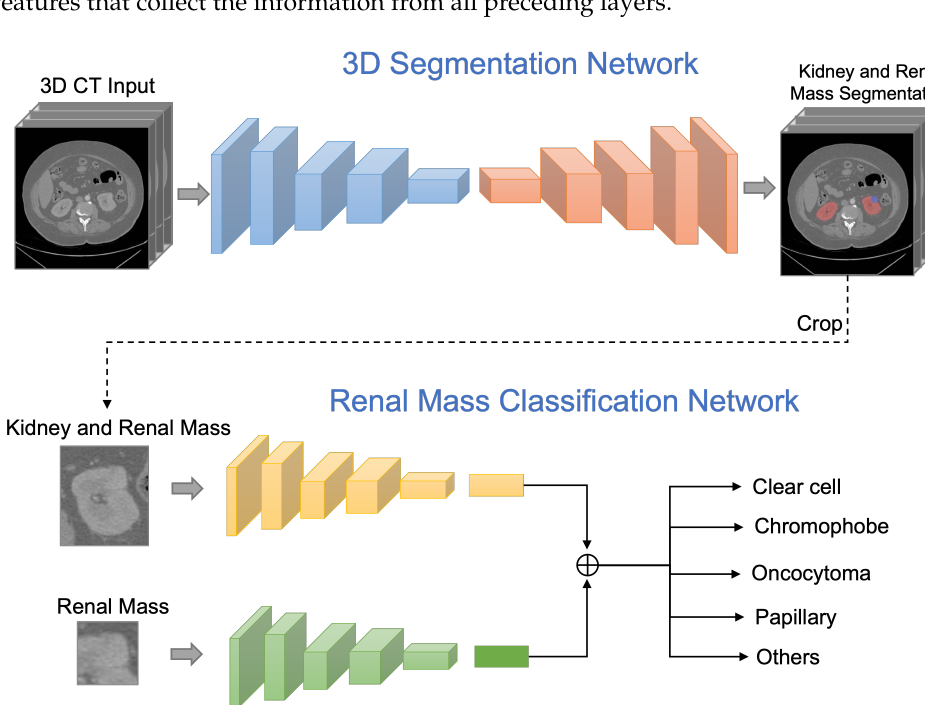
Figure 1. The proposed framework first predicts the kidney and renal mass regions via a 3D segmen- tation network. The classification network then takes the inputs of the regions of renal mass and renal mass with kidney, then outputs a probability distribution over subtype classes of the renal